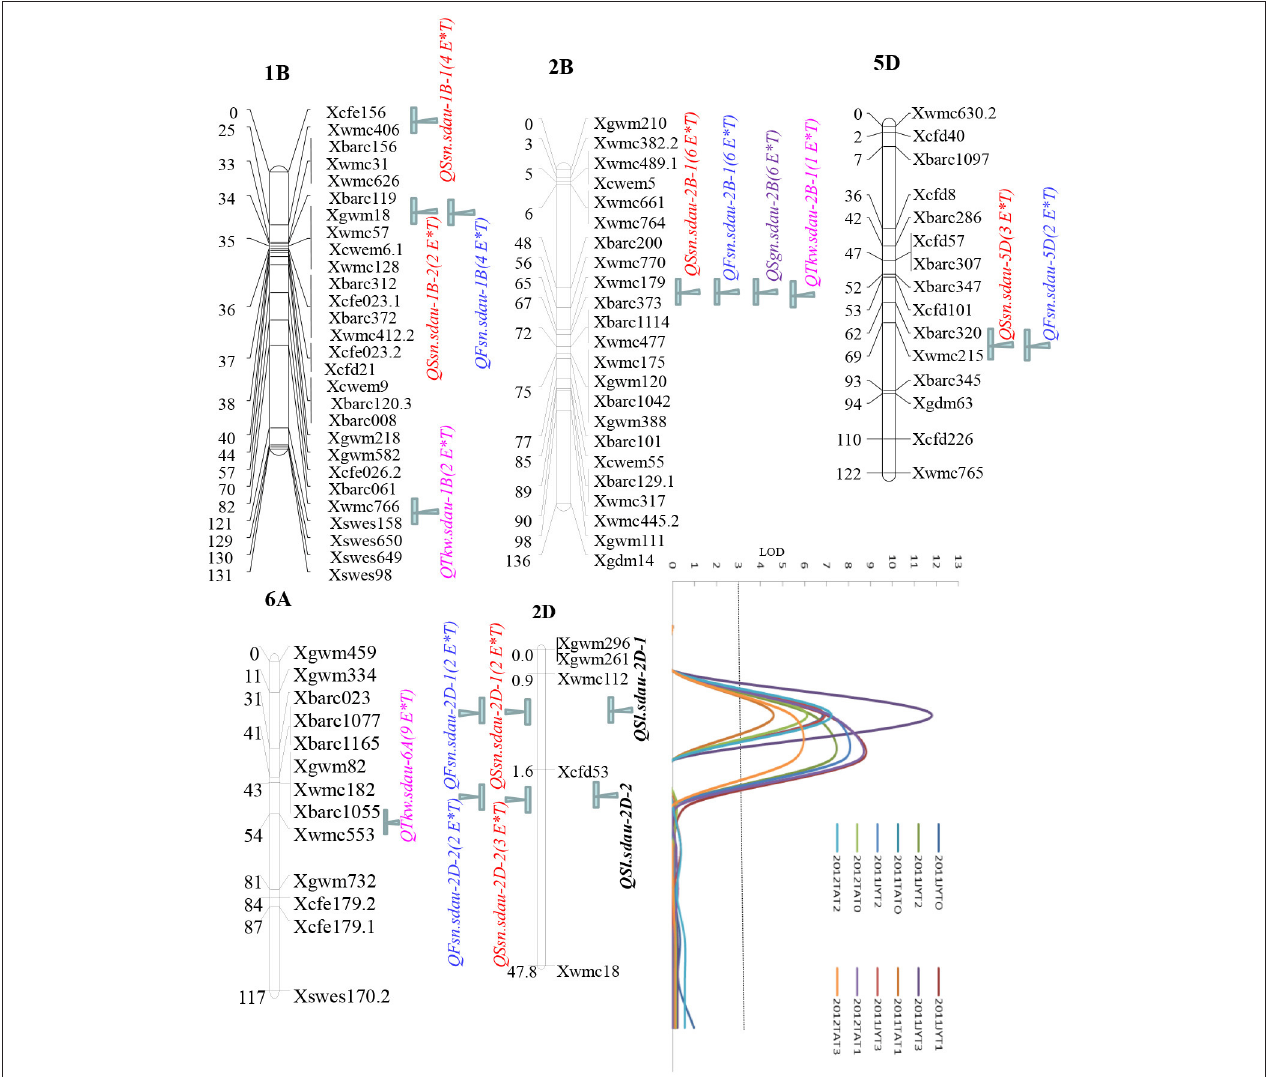
FIGURE 2 | Linkage maps of important chromosome regions and co-localizing QTLs. LOD curves for QTLs were obtained from inclusive composite interval mapping (ICIM) of Sl under different nitrogen supply dates in the different locations and years. The horizontal dashed-dot line indicates the LOD threshold of 3.0 determined by permutations. E × T indicates environment × treatment. QTLs for Ssn, Fsn, Gns, Tkw, and Sl are shown in red, blue, purple, pink and black,